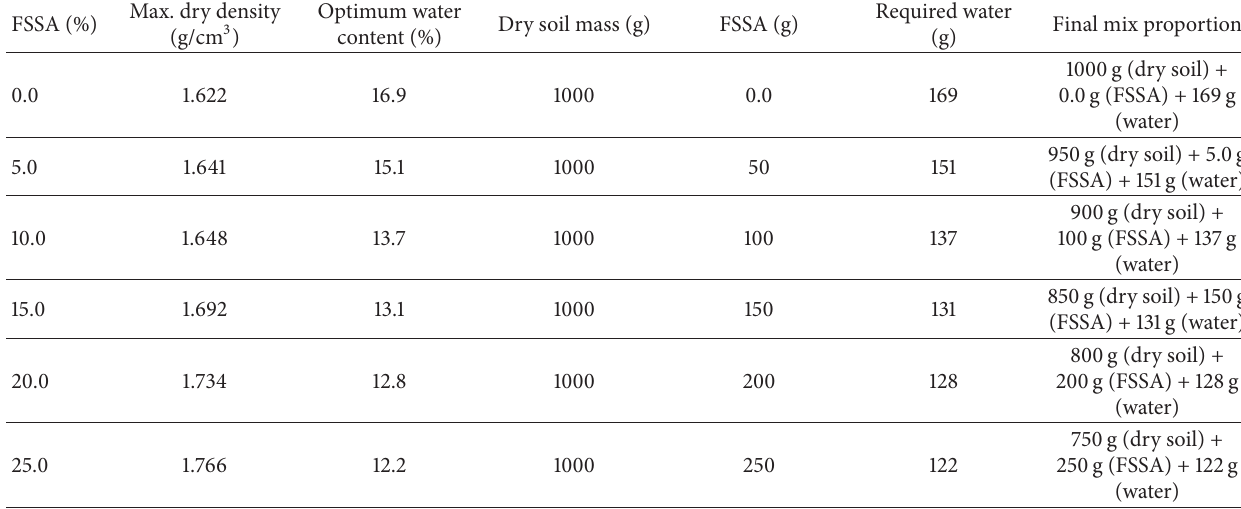
Table 4: Mix proportions used in preparing